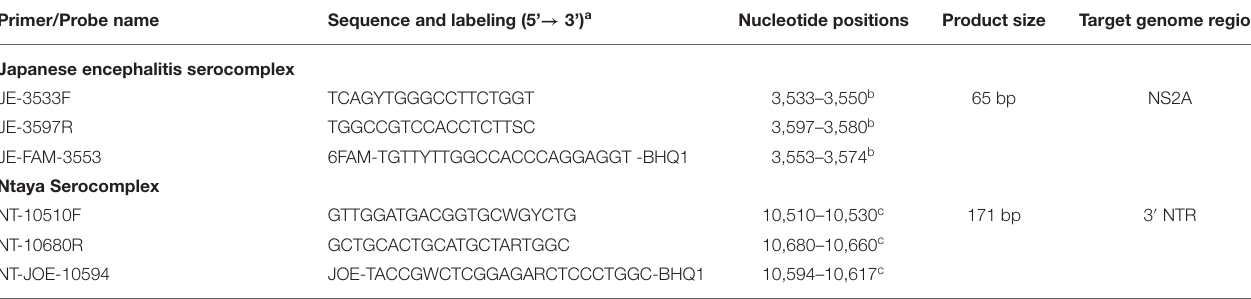
TABLE 3 | List of primers and probes designed for the detection of JE and Ntaya serocomplexes by dRRT-PCR